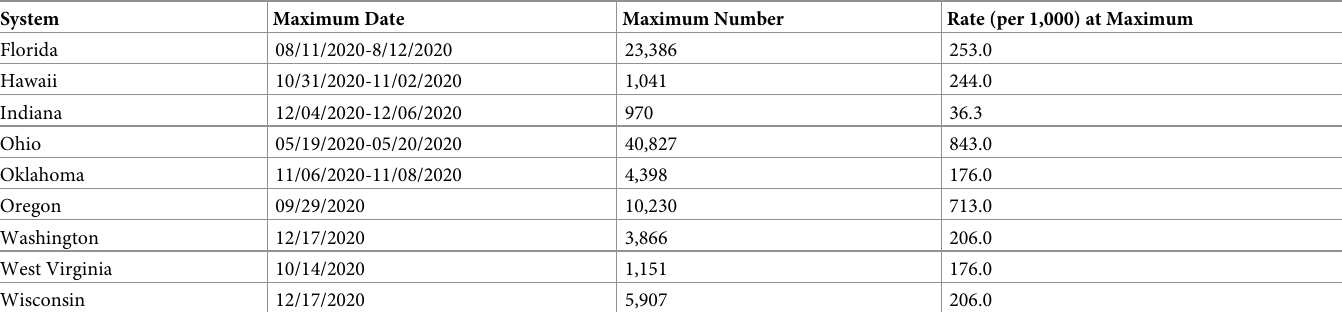
Table 3. Maximum numbers and rates for quarantine